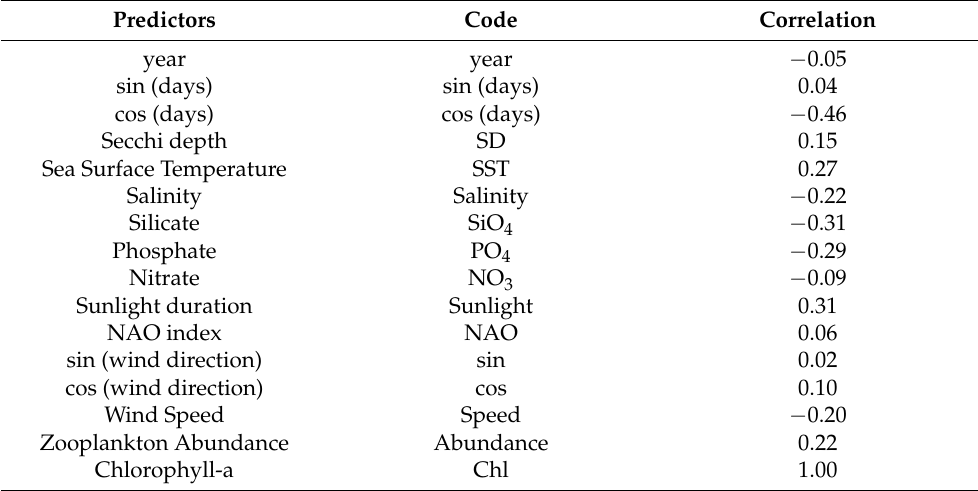
Table 2. Pearson correlation among predictors and the target chlorophyll-a concentration.